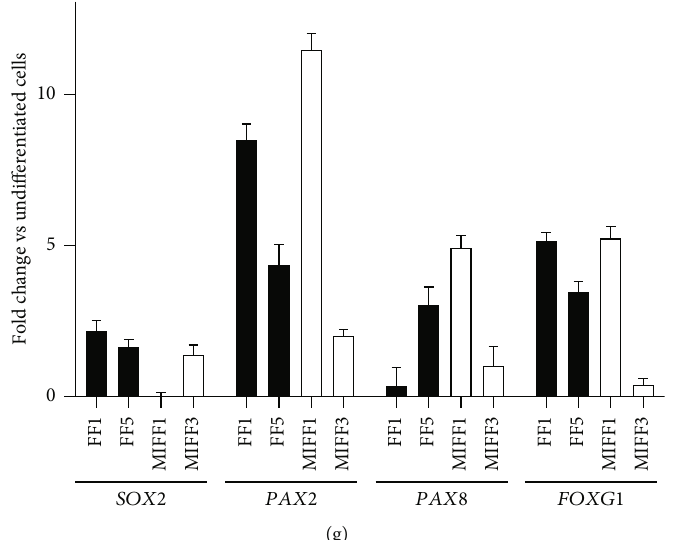
Figure 1: (a) Diagram showing the protocol for the generation of otic progenitors. Colonies of ONPs (b) and OEPs (c), displaying their typical morphology. Scale bar, 200 μ m. (d) Bar chart displaying the relative yields of OEPs and ONPs per reprogramming condition (dark bars are lentivirus-reprogrammed lines, while open bars are for mRNA-reprogrammed ones). (e) Top: ONP colony stained for SOX2 and PAX8. Bottom: otic epithelial progenitors showing coexpression of FOXG1 and PAX8. Images shown are from the FF1 cell line. Scale bar, 400 μ m. (f) Bar charts displaying percentages of double-positive otic progenitors, expressing high levels of SOX2/PAX8, FOXG1/PAX8, and PAX2/PAX8. (g) qPCR of otic progenitors showing relative levels of expression for SOX2 , PAX2 , PAX8 , and FOXG1. Data shown as fold change against undi ff erentiated cells from the same starting